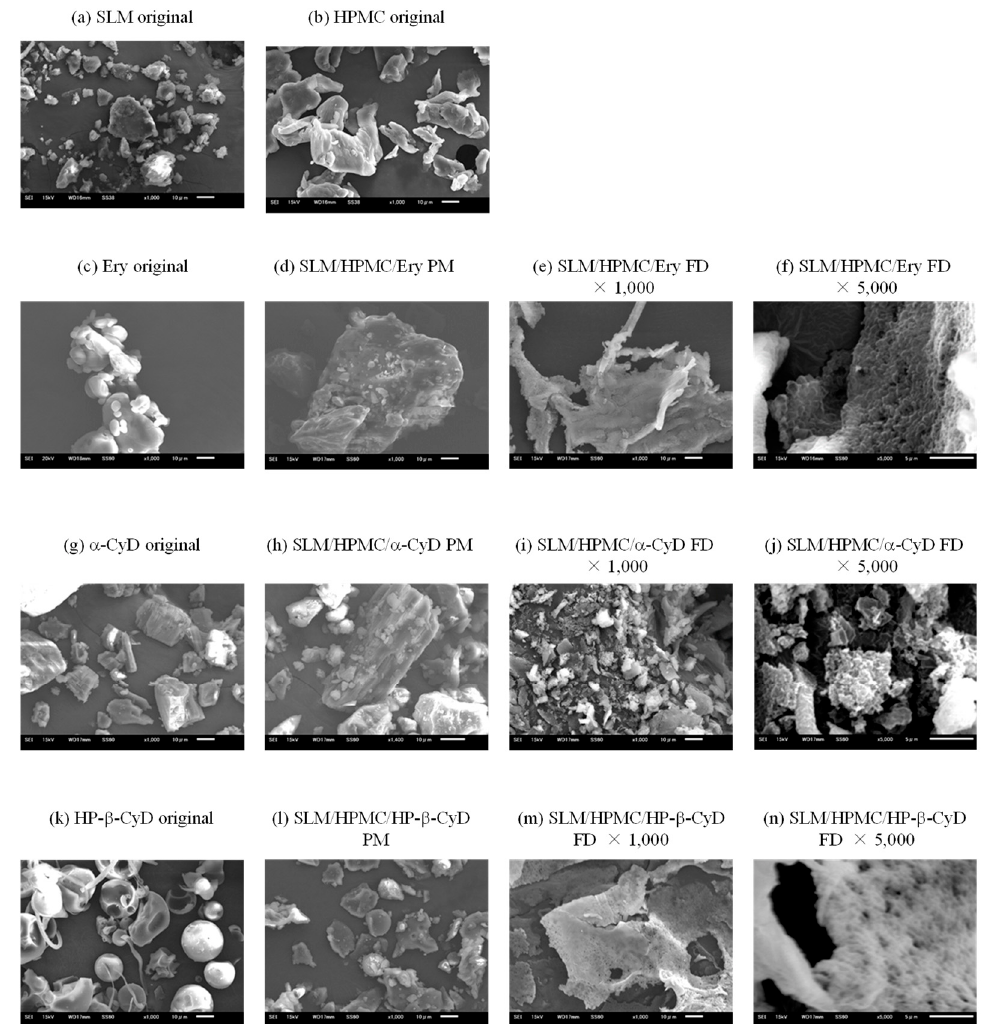
Figure 2. Morphological observation of silymarin (SLM), hypromellose (HPMC), erythritol (Ery) and SLM/HPMC/Ery nanoparticles (NPs). The weight ratio of SLM/HPMC/stabilizers was 1/1/1. The experiments were performed independently thrice, and representative images are shown. X-ray diffraction patterns of various samples. ( a ) Silymarin (SLM) original, ( b ) hypromellose (HPMC) original, ( c ) erythritol (Ery) original, ( d ) SLM/HPMC/Ery physical mixture (PM), ( e , f ) SLM/HPMC/Ery freeze dry (FD), ( g ) α -cyclodextrin ( α -CyD) original, ( h ) SLM/HPMC/ α -CyD PM, ( i,j ) SLM/HPMC/ α -CyD FD, ( k ) hydroxypropyl (HP)- β -CyD original, ( l ) SLM/HPMC/HP- β -CyD PM, ( m , n ) SLM/HPMC/HP- β -CyD FD. The weight ratio of SLM/HPMC/stabilizers was 1/1/1.